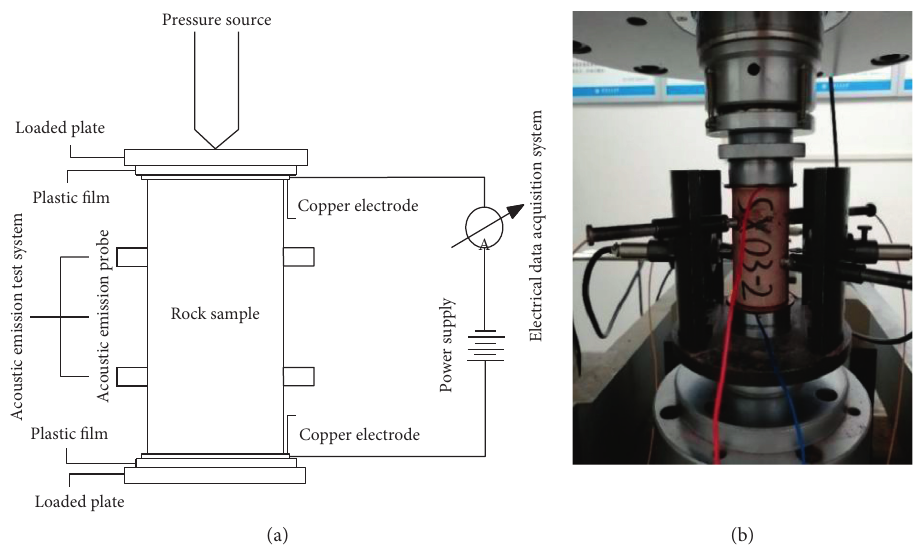
Figure 1: Experimental device. (a) Design of test system. (b) Acoustic emission-resistivity-stress synchronous test.